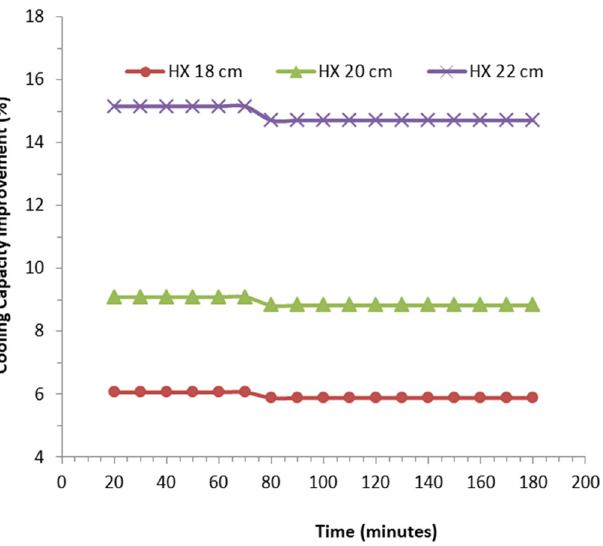
Figure 7. Cooling-capacity improvements of air conditioner using condensate water as a subcooler for three different lengths of heat exchangers.